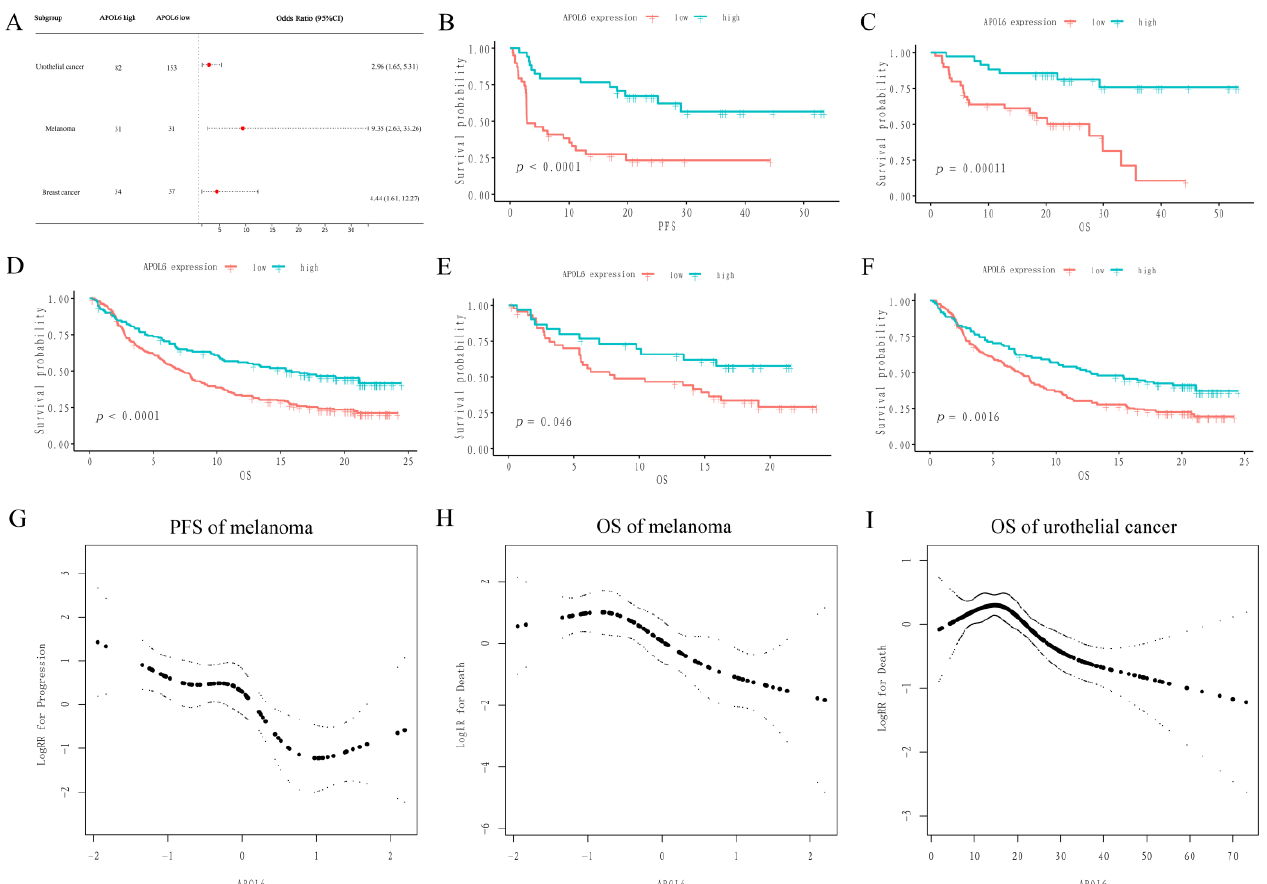
Figure 2. The upregulation of APOL6 correlated with better immunotherapy response and prognosis across multiple tumor types. ( A ) Forest plot of the odds ratios for the response to immunotherapy across multiple tumor types. ( B , C ) Kaplan-Meier curves of PFS ( B ) and OS ( C ) in melanoma patients receiving anti-PD1 therapy or a combination of anti-PD1 and anti-CTLA4 immunotherapy. ( D – F ) Kaplan–Meier curves of OS in all urothelial cancer patients ( D ), cisplatin-refractory urothelial cancer ( E ), and cisplatin-ineligible urothelial cancer patients ( F ) from the IMvigor210 cohort. ( G – I ) Fit curves obtained from restricted cubic smoothing demonstrate the relationship between APOL6 expression and the risk of progression or death. The thick lines and thin lines represent the estimated values and corresponding 95% confidence intervals, respectively. Table 3. Univariate and multivariate analyses of factors associated with patient survival in the mel- anoma cohort receiving immunotherapy.